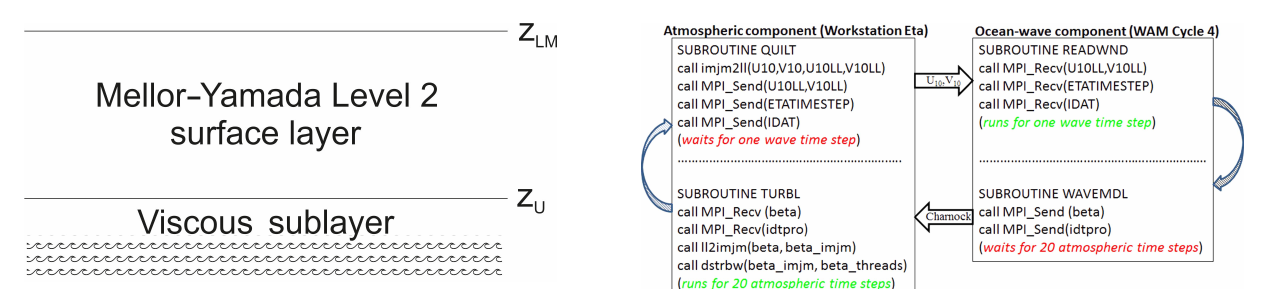
Figure 3. The WEW exchanges near-surface U,V components, and Charnock coefficient every time step of the ocean wave model.